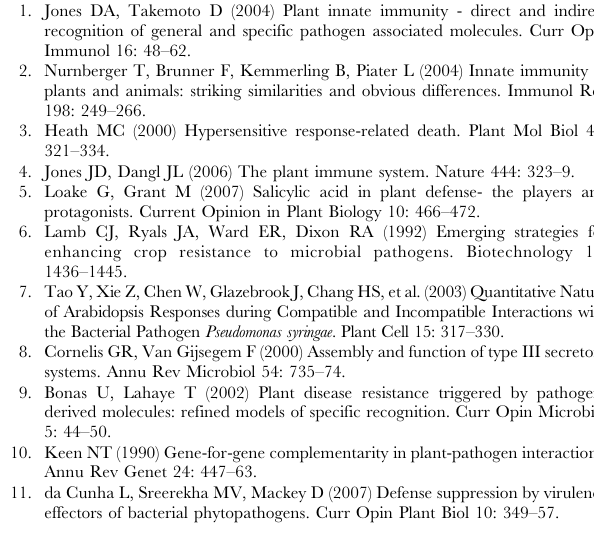
Table S7 List of Arabidopsis knockout lines tested for their response towards R. solanacearum . Up- and down-regulated genes 5 days post inoculation in both compatible interactions (Col-5/ GMI1000) (A and B, respectively).